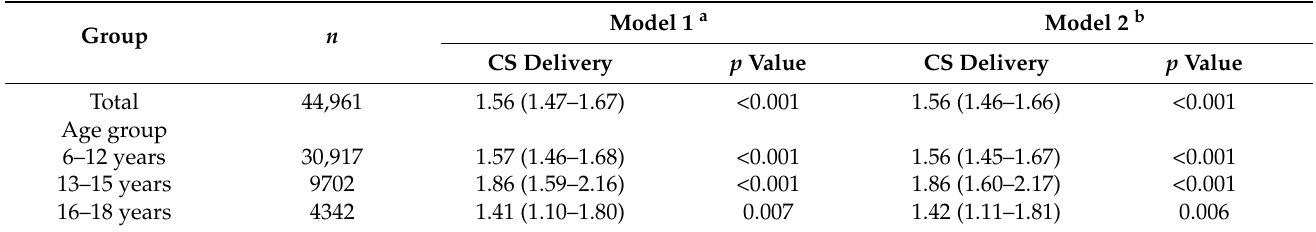
Table 2. Association between delivery mode and obesity in children and adolescents aged 6–18 years.